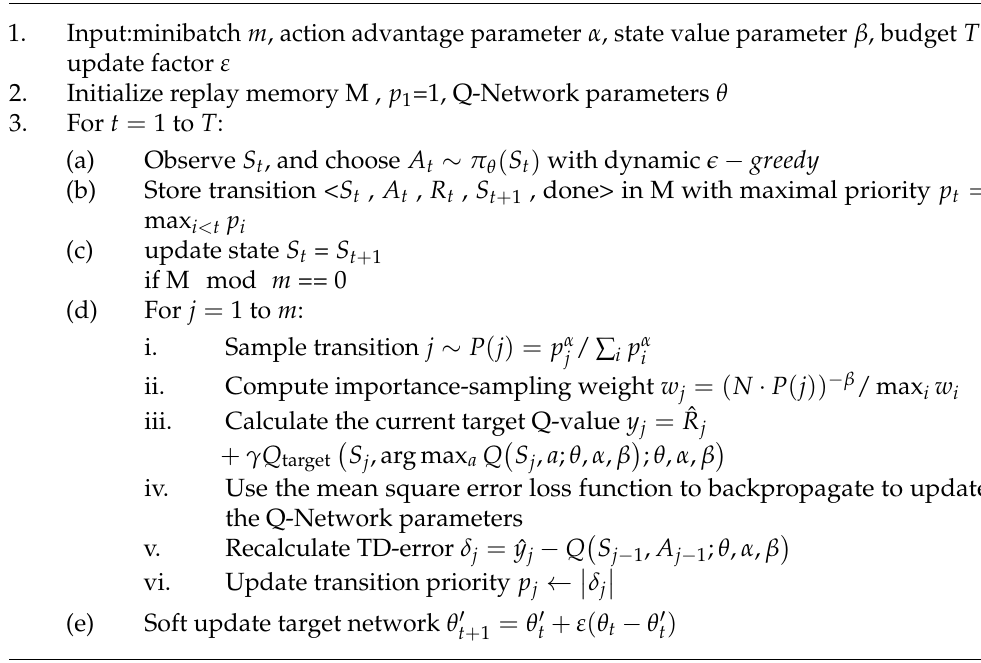
Algorithm 1 Improved Dueling Double Deep Q-Network Based on Prioritized Experi- ence